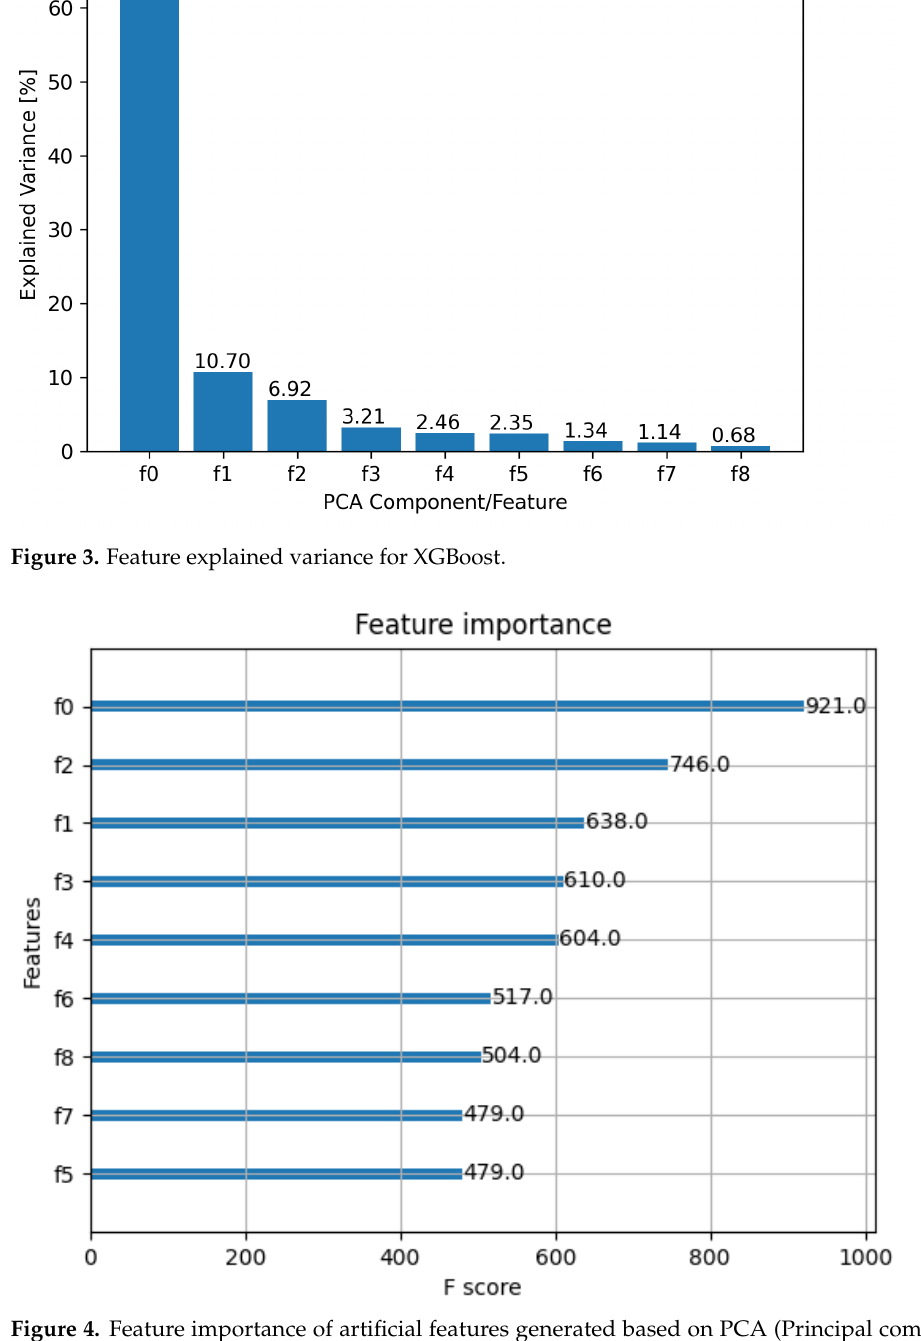
Figure 4. Feature importance of artificial features generated based on PCA (Principal component